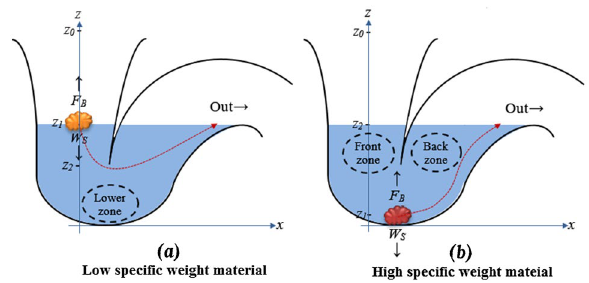
Fig. 1 A schematic diagram of wastes path in the lavatory